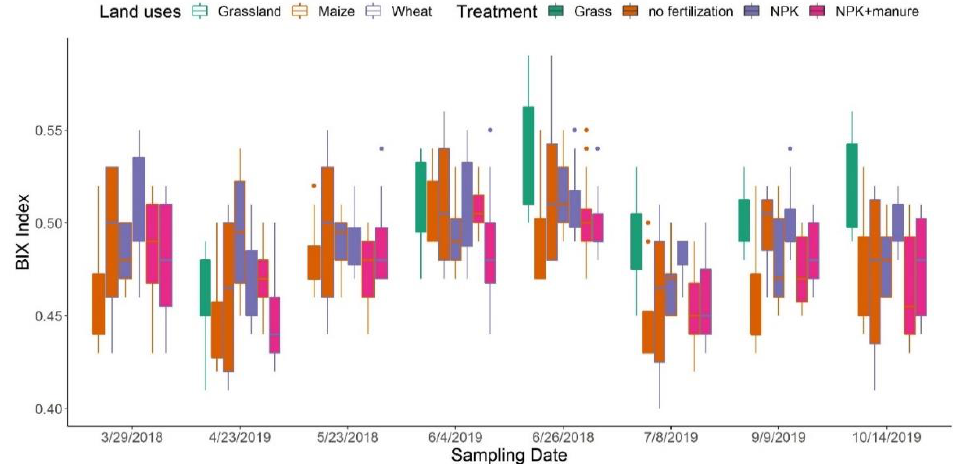
Figure 4. Biological index (BIX) values on cropland and grassland sites under different treatments and across crop cover. Sample size was n = 12 for each treatment and crop cover, total sample size was n = 648; dots indicate outliers. NPK: nitrogen, phosphorus, potassium fertilization.